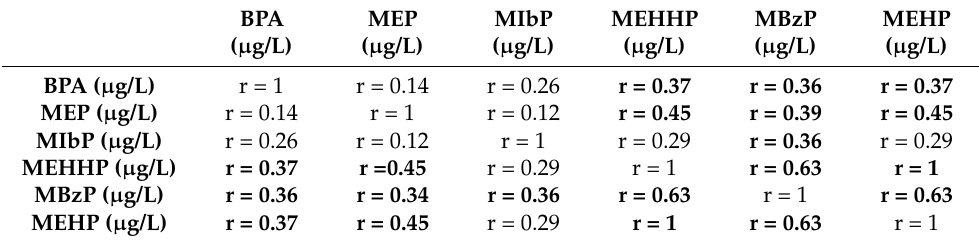
Table 5. Pearson’s correlation coefficients among phthalates and BPA.